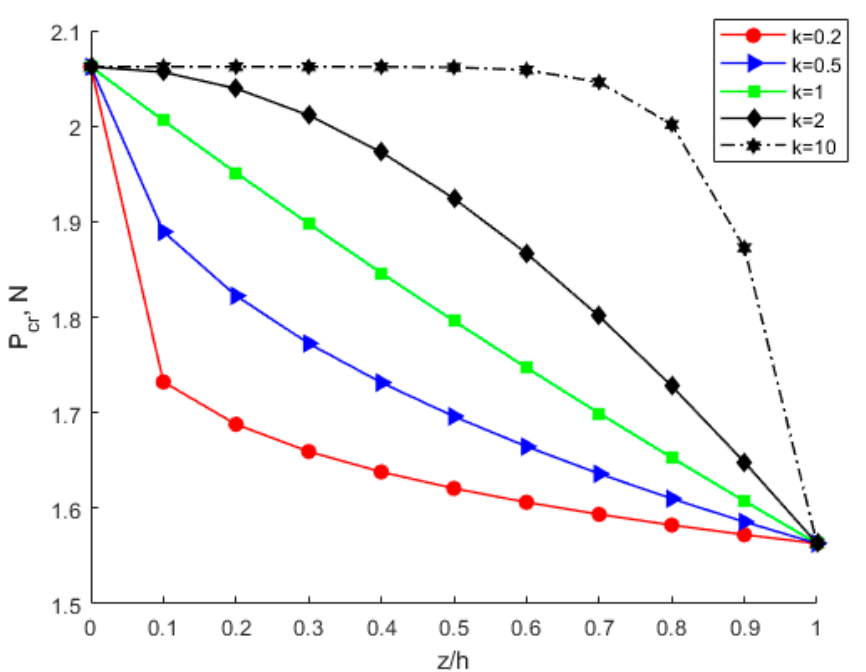
Figure 17. Influence of power-law index parameters on the critical buckling load when l = 0.